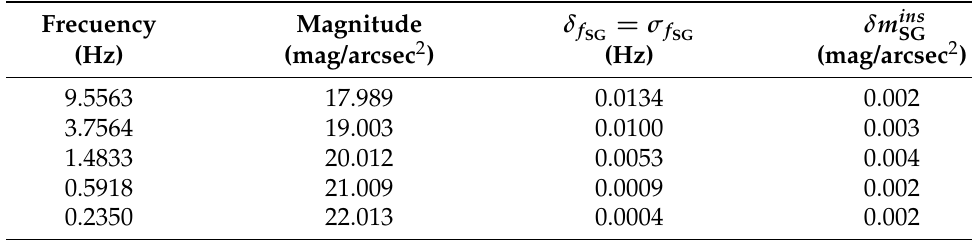
Table 1. Frequency standard deviation values for each distribution. Following Equation (5), the SG- WAS instrumental magnitude, δ m ins , was also calculated. SG